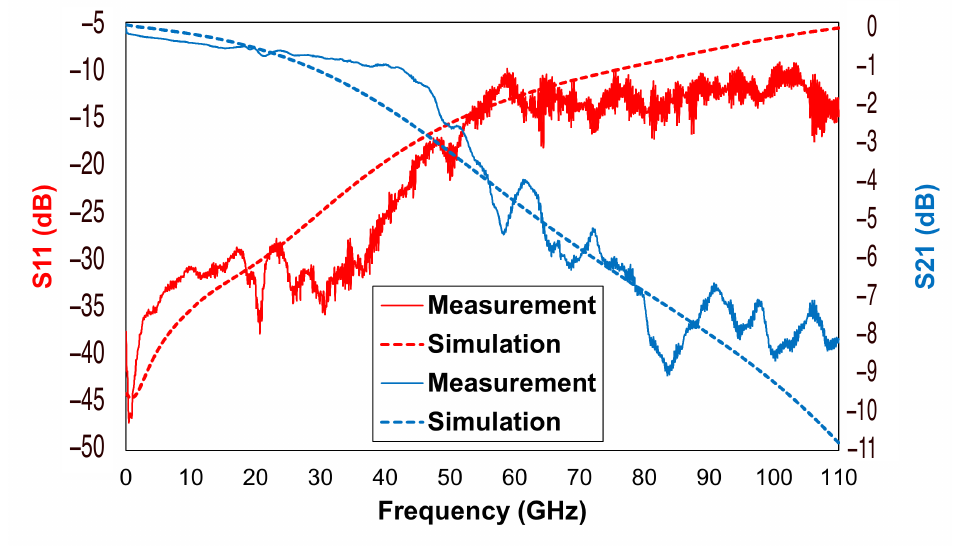
Figure 8. Comparison between the simulated and the measured electromagnetic characteristics of the discussed RF-MEMS switch, in its CLOSE